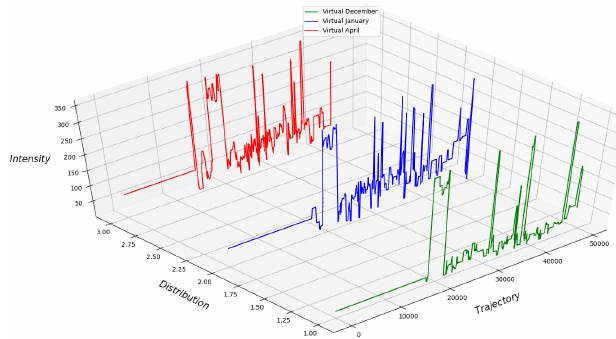
ti to Deva (via Sibiu) with ,